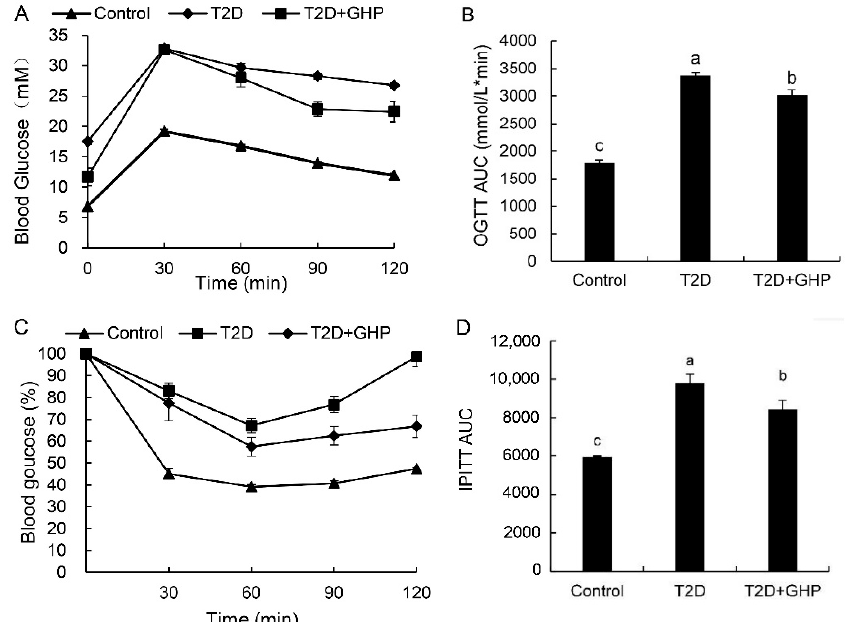
Figure 2. GHP supplementation recovers glucose tolerance and insulin tolerance in T2D mice. Changes in glucose levels during Oral Glucose Tolerance Test (OGTT) ( A ) and the Intraperitoneal Insulin Tolerance Test (IPITT) ( C ). The area under the curve (AUC) of the glucose level during the OGTT ( B ) and IPITT ( D ). Results were expressed as means ± SEM ( n = 8). Different letters (a–c) indicate significant difference ( p < 0.05).